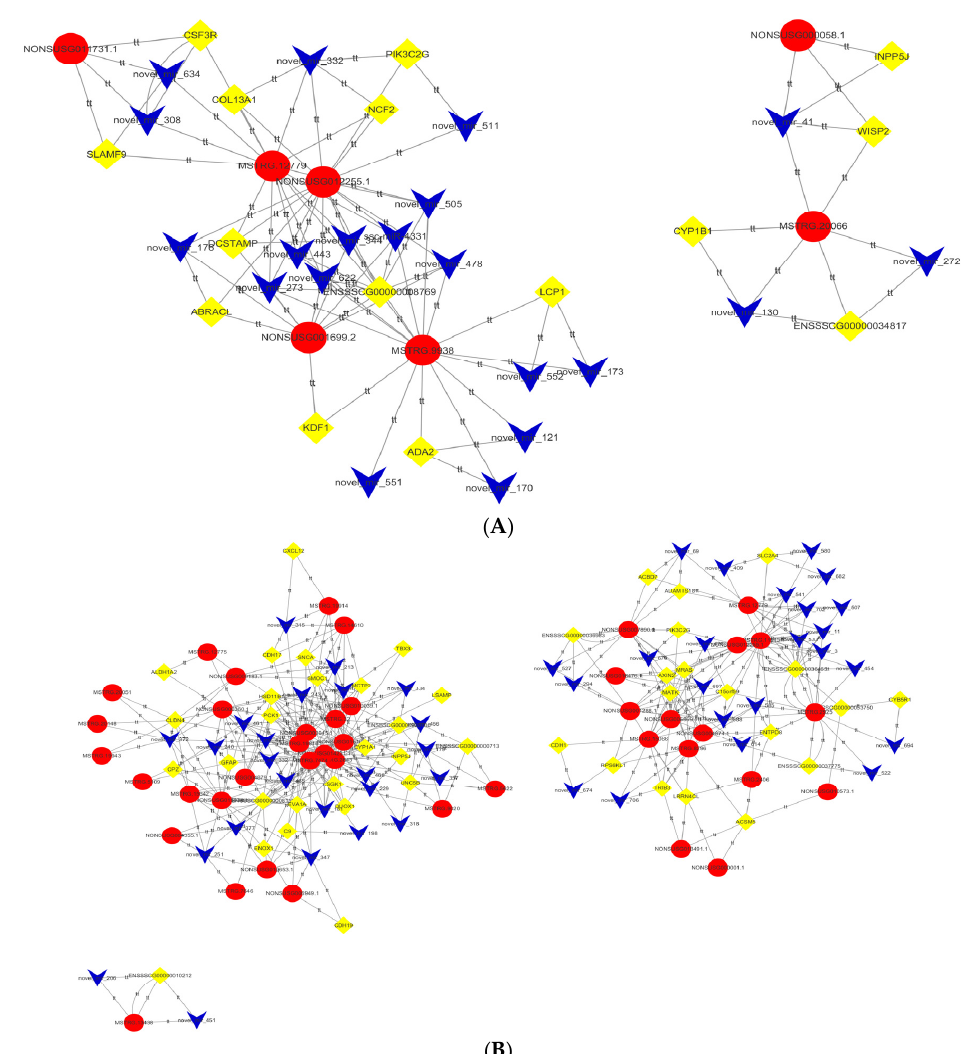
Figure 4. Construction of the ceRNA network. ( A ). The ceRNA network is composed of miRDElncRNAs, DEmiRNAs and DEmRNAs from castrated and intact pig back adipose tissue. ( B ). The ceRNA network is composed of miRDElncRNAs, DEmiRNAs and DEmRNAs from castrated and intact pig adipose tissue . Circle indicates DE lncRNAs, rhombus indicates DE mRNAs, V shape indicates DE miRNAs.